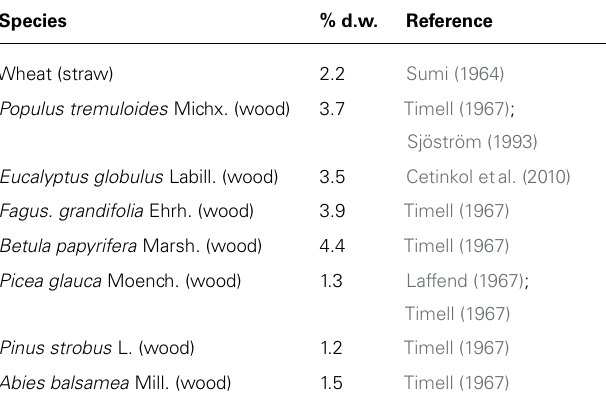
Table 1 |Acetyl contents in lignocellulose from some common woody lignocelluloses in comparison to wheat straw. Species %